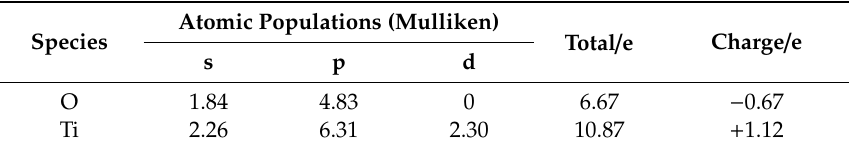
Table 1. Average Mulliken populations of atoms in Ti 3 O 5 crystal.